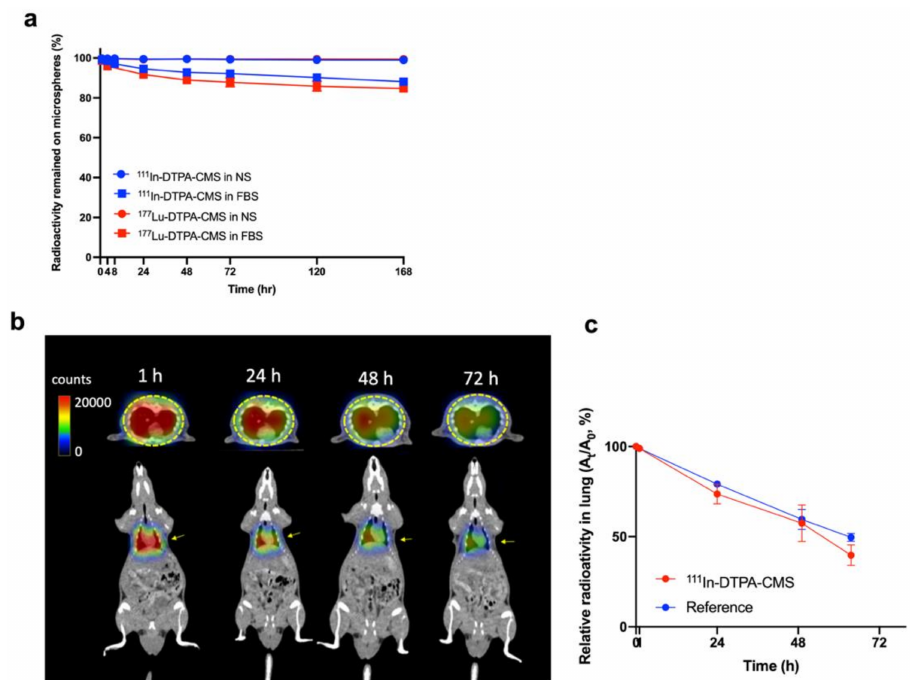
Figure 3. Stability of radiolabeled chitosan microspheres. ( a ) In vitro stability of 111 In- and 177 Lu- DTPA-CMS in either normal saline at room temperature or fetal bovine serum at 37 ◦ C ( n ≥ 5). ( b ) In vivo stability of radiolabeled chitosan microspheres determined by the SPECT images of rats receiving an intravenous injection of 111 In-DTPA-CMS at 1, 24, 48, and 72 h post-injection ( n ≥ 3). ( c ) Quantification of lung uptake at each time point. The reference values were obtained from the Eppendorf containing 111 In-InCl 3 placed in a remote area of the field of